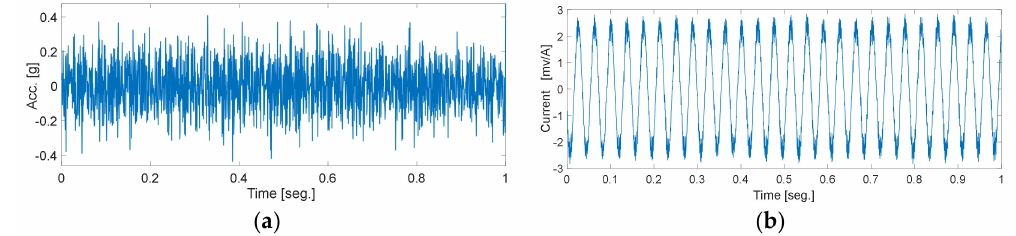
Figure 5. Raw data from the same time step. ( a ) Time domain raw vibration signal and ( b ) raw current signal.